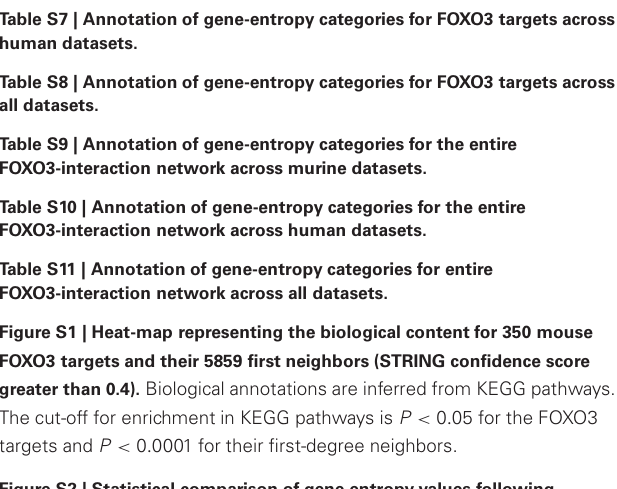
permutation analysis in FOXO-interaction networks. Increasing